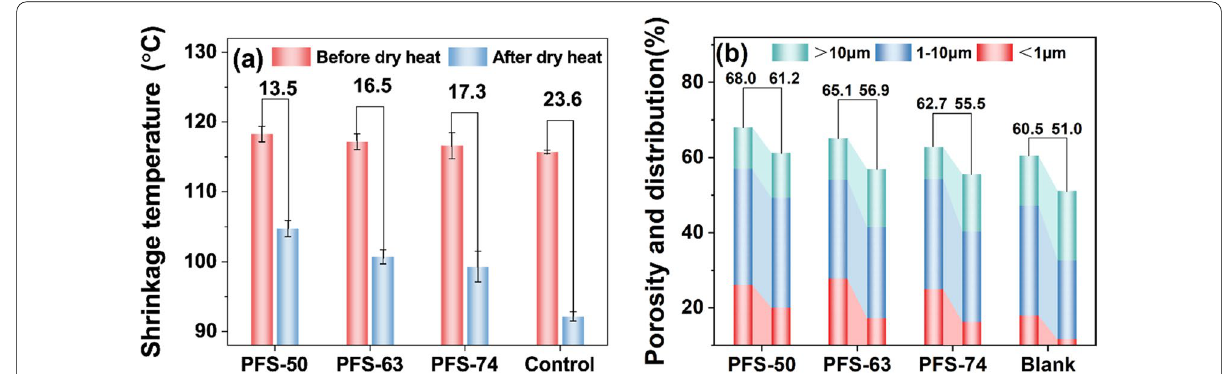
Fig. 7 The a shrinkage temperature and b porosity of retanned leathers before and after dry heat resistance